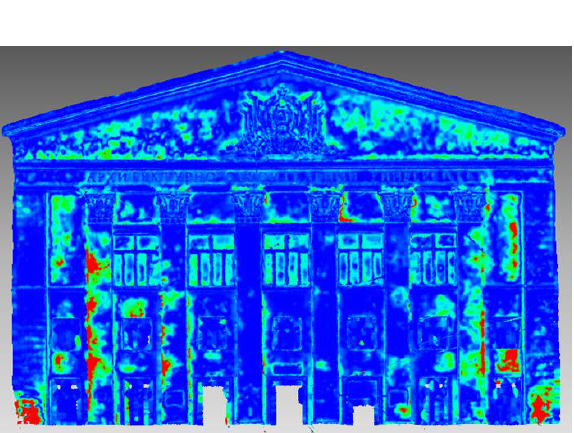
Figure 9. Map of the absolute deviations between three- dimensional vector models The diagram of the Gauss-Laplace distribution is shown in Fig. 10 and the map color graduation of absolute deviations between three-dimensional vector models is shown in Fig.